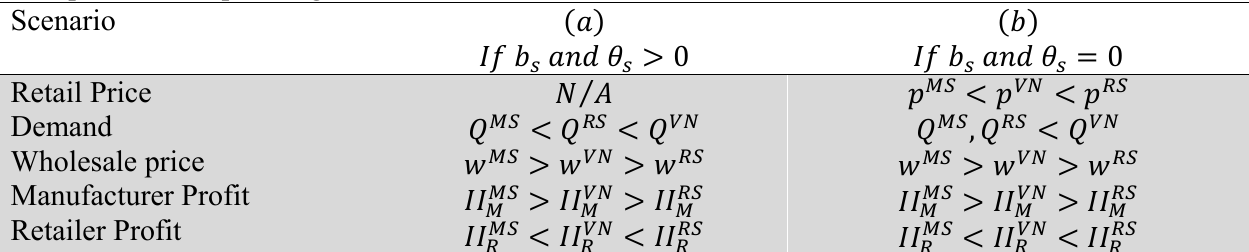
Comparison of n-person game